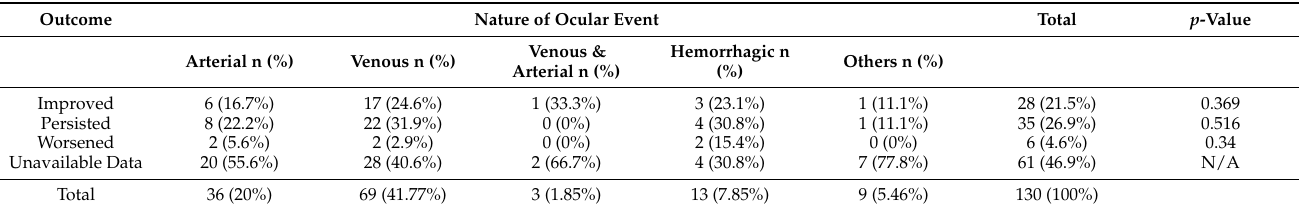
Table 5. The overall outcome for included